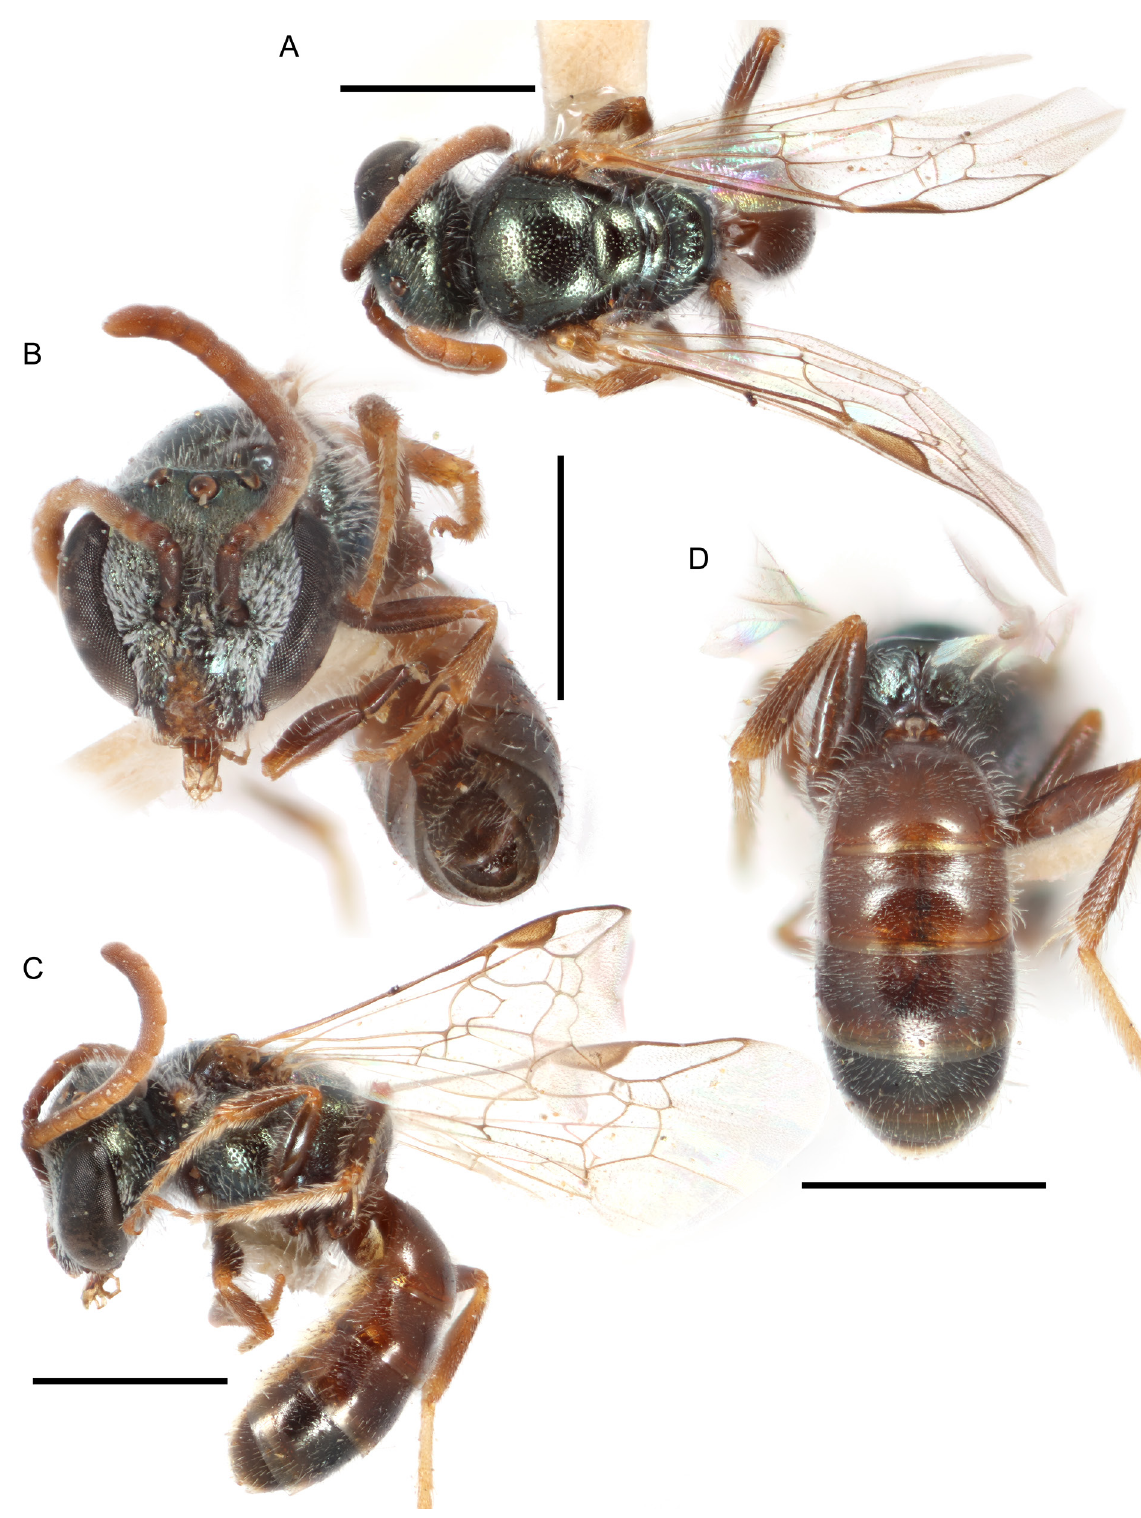
Fig. 14. Lasioglossum ( D. ) austerum sp. nov., ♂. A . Dorsal habitus. B . Face. C . Lateral habitus. D . Propodeum and metasoma. Scale bars: 1